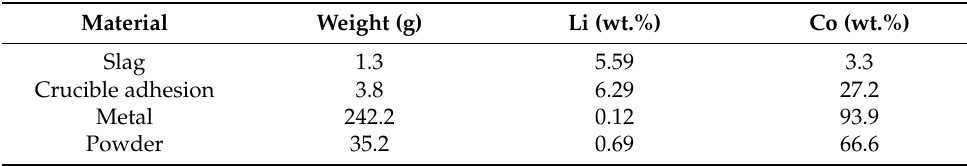
Table 5. Results from the experiment LCO-C in Design 2.